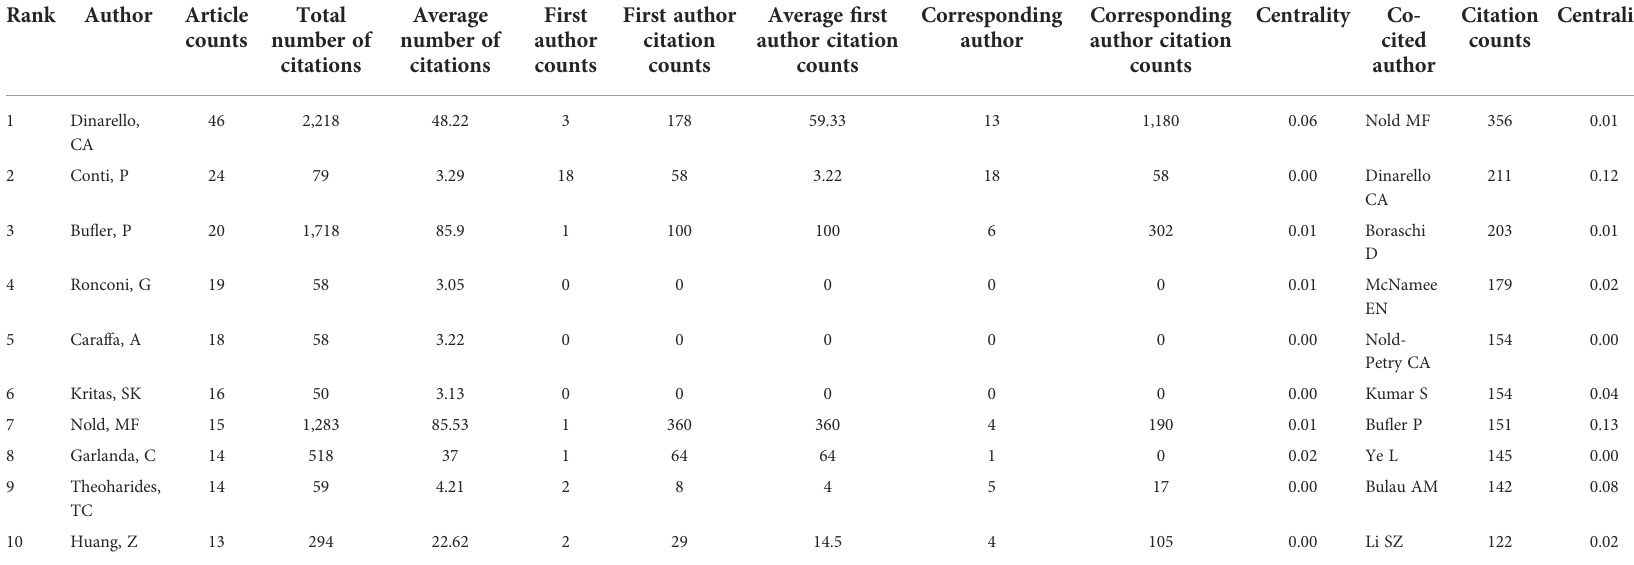
TABLE 3 The top 10 most productive authors and co-cited authors contributed to IL-37